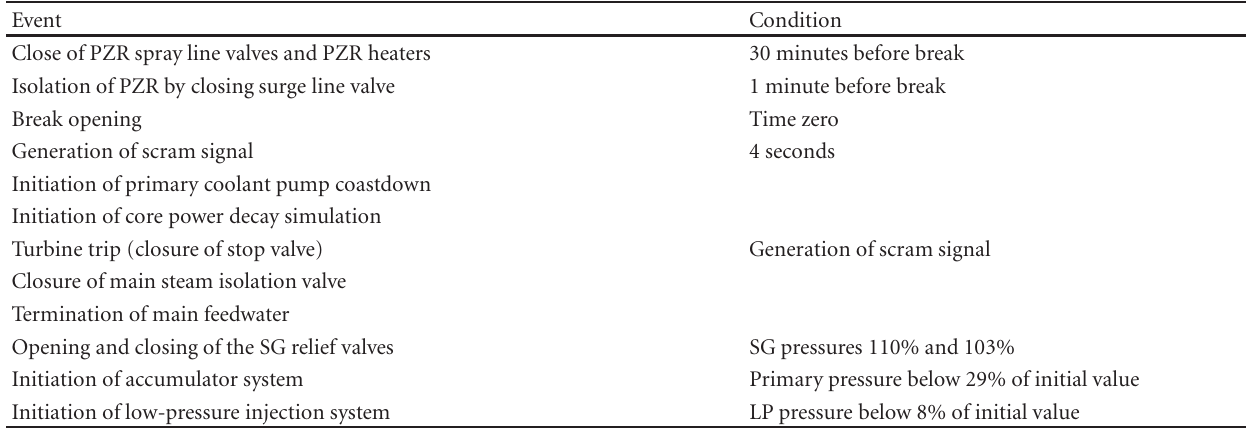
Table 6: Control logic of Test 1 [10].